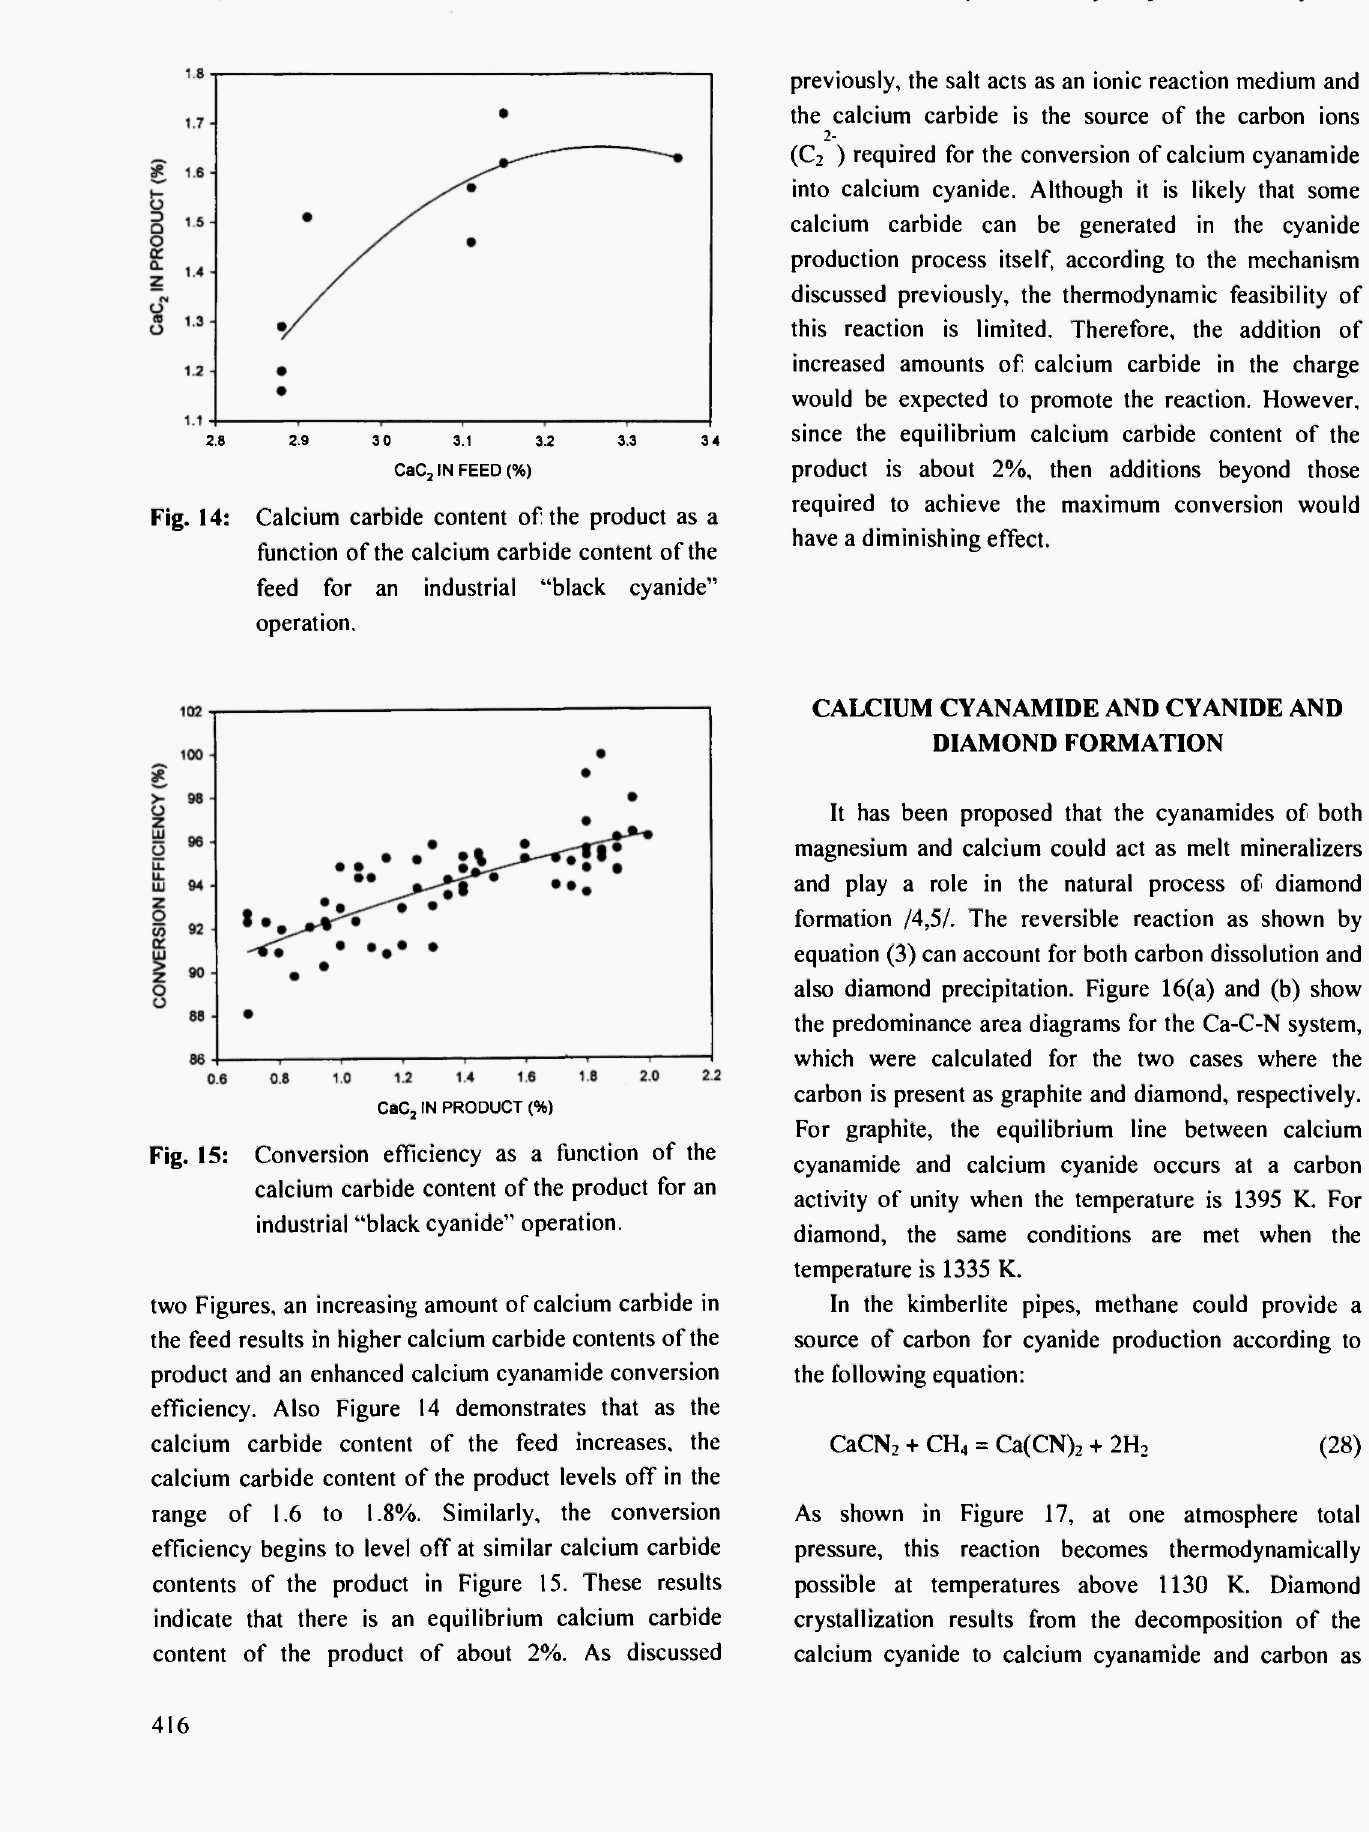
Fig. 14: Calcium carbide content of the product as a function of the calcium carbide content of the feed for an industrial "black cyanide" operation.